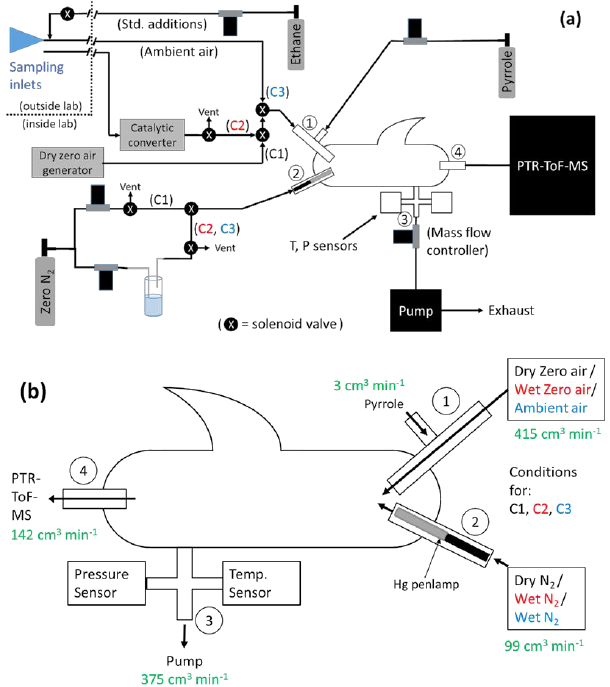
Figure 1. Schematic of (a) the entire CRM instrument and (b) the CRM reactor (adapted from Sinha et al., 2008b). In panel (a) , gas line connections are indicated by solid black lines. Conditions for the C1, C2, and C3 measurements are represented in both panels by black, red, and blue fonts, respectively. Typical flows through each arm are shown in green fonts adjacent to the respective arms in panel (b)